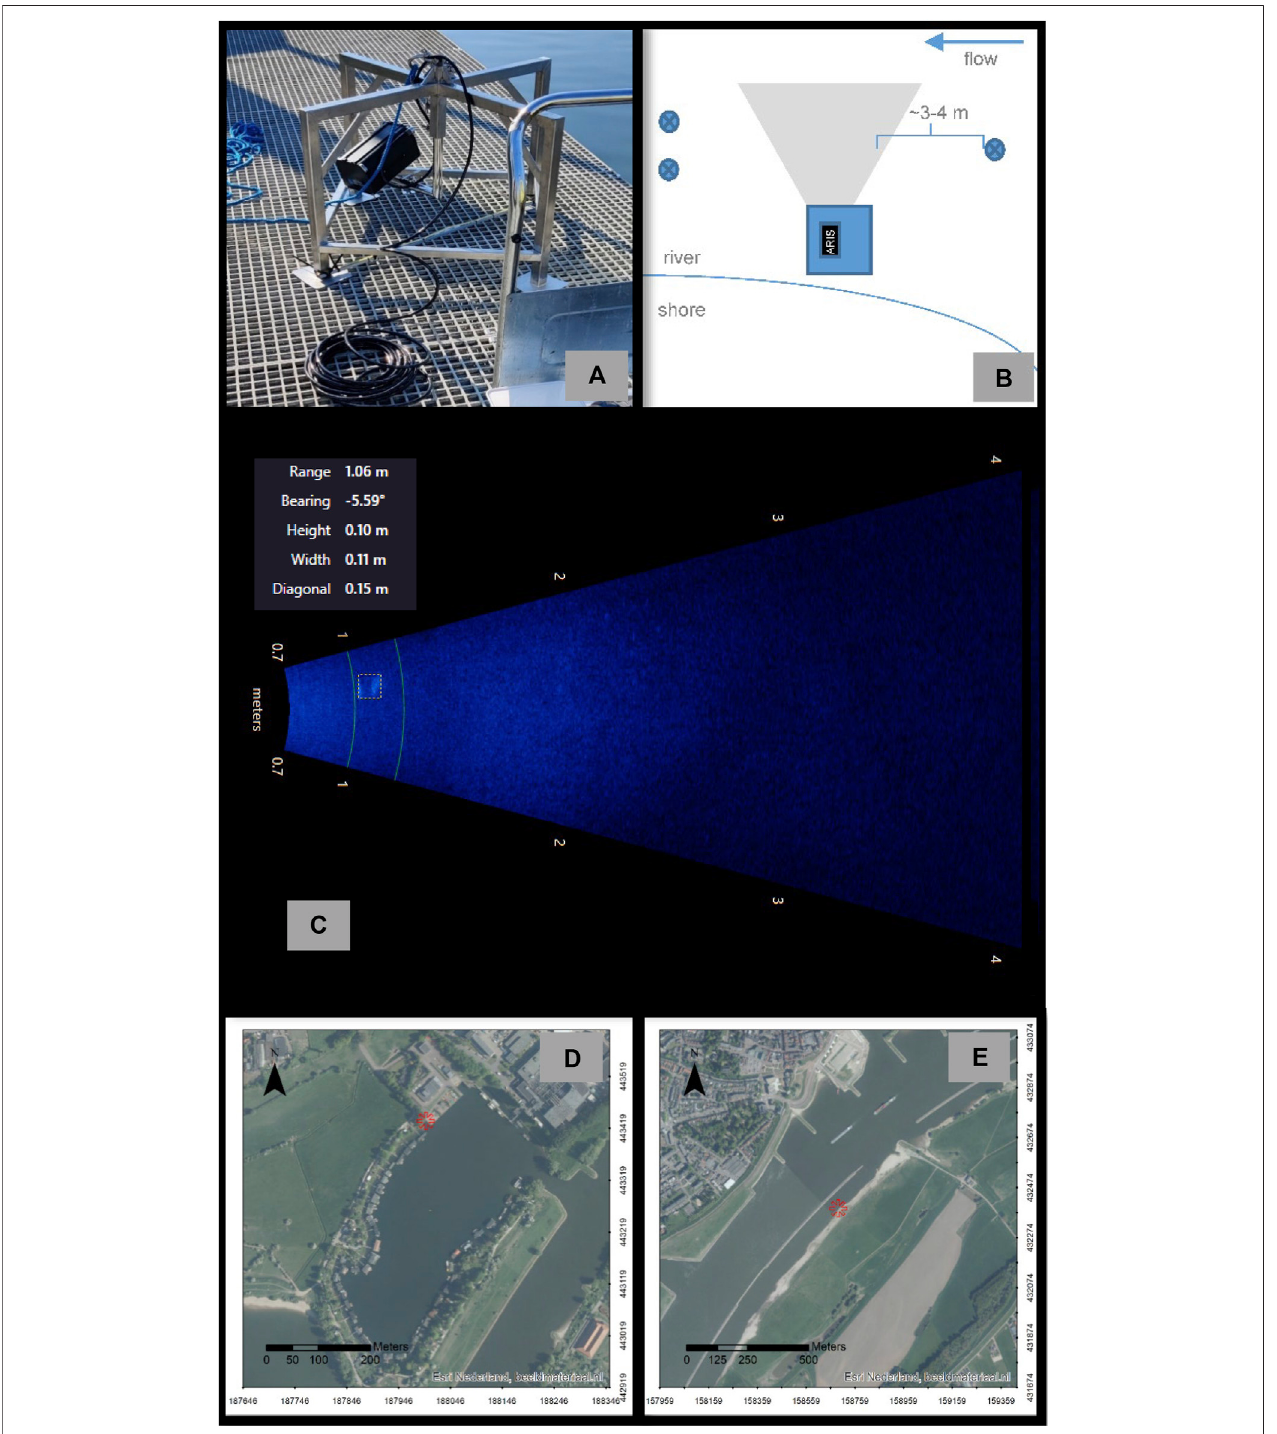
FIGURE 1 | (A) The ARIS sonar installed on the mount as used for both the standing water and fl owing water tests, (B) schematic drawing of the set-up for the fl owing water test (the circles with crosses indicate one wading person standing upstream and two standing downstream of the sonar to release and catch the macroplastics, respectively, (C) the beams fan of the ARIS sonar as seen in ARISFish software near the centre at 1.06 m range a macroplastic (11 × 10 cm) recorded during data collection performed in April, 2021, (D) map of the Rosandepolder RWS facility used for the ARIS standing water test, and (E) map of the sheltered shore channel site used for the ARIS fl owing water test. The exact locations are denoted by the red asterisk. Photo by N.Y. Flores. Aerial images source: Environmental Systems Research Institute (ESRI) Nederland, beeldmateriaal.nl.